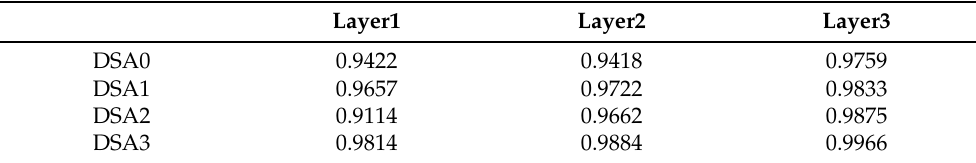
Table 1. AUC-ROC of corner case data detection based on DSA.